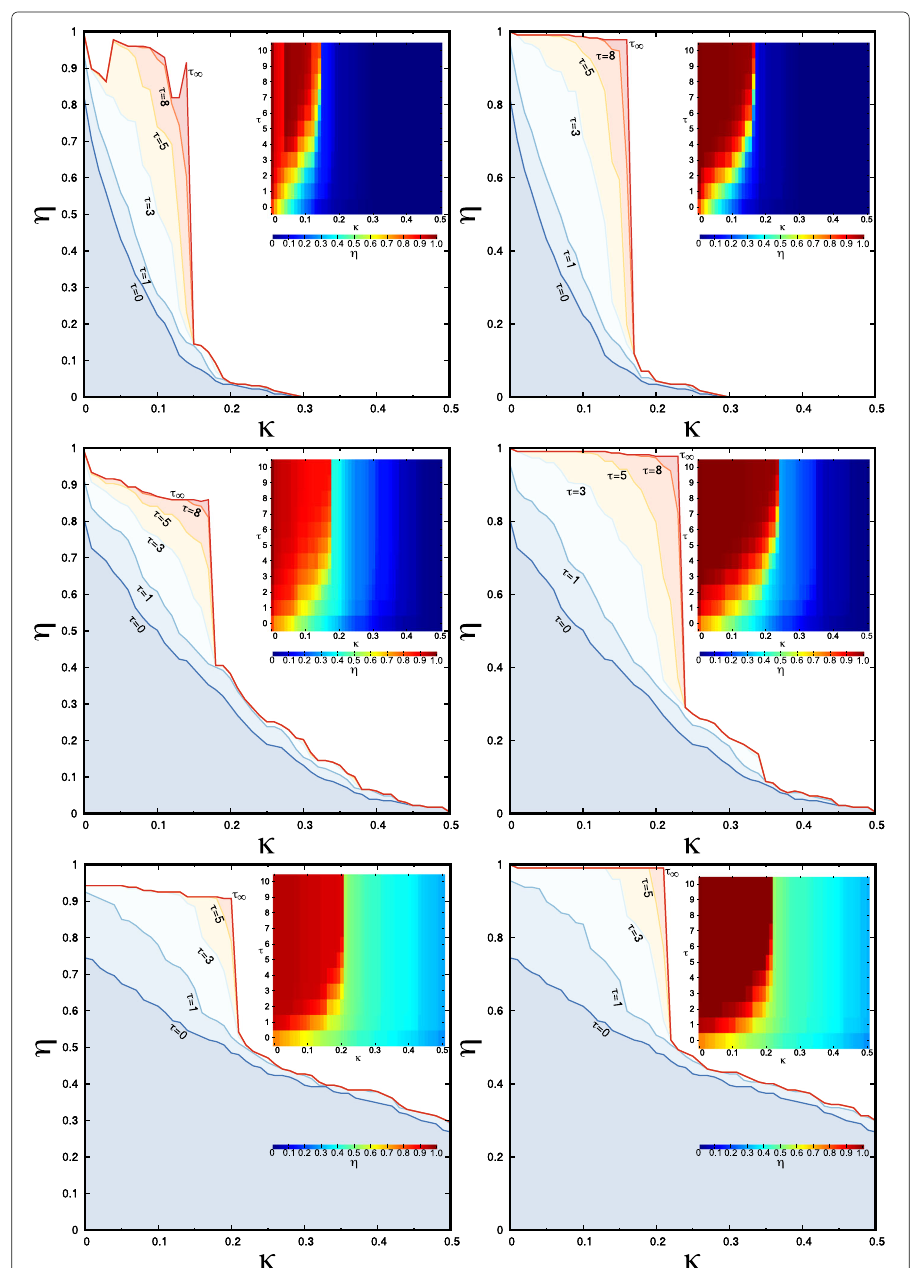
Fig. 2 Fraction of bankrupted countries for the 2016 WTN. Fraction η of countries went to bankruptcy up to the τ th stage of the crisis contagion as a function of the bankruptcy threshold κ . For the first column, once a country goes to bankruptcy, it is prevented to import products with the exception of petroleum and gas (model A). For the second column, once a country goes to bankruptcy, it is prevented to import any product (model B). The first (second) row corresponds to a damping factor α = 0.5 ( α = 0.85). The evolution of the fraction of bankrupted countries is monitored by the PCTB (4) (first and second rows) and by the ImportRank-ExportRank balance (5) (third row). The insets show the corresponding fraction η of bankrupted countries in the ( τ , κ ) plane. Dark red corresponds to the case where all the countries went to bankruptcy ( η = 1), and dark blue to the case where all the countries are safe ( η =